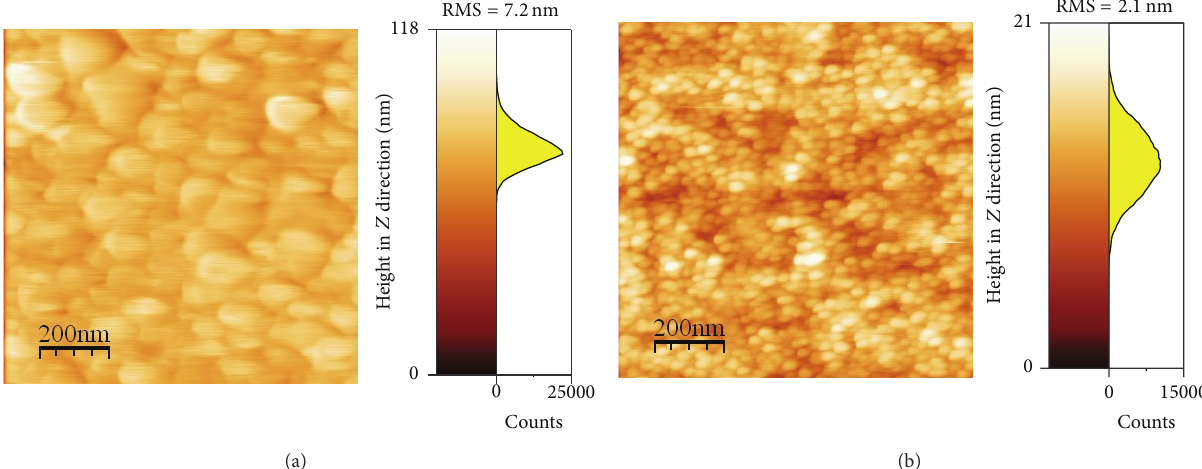
Figure 2: AFM images of (a) TiO 2 thin film and (b) TiO 2 :Tb thin film with height distribution of grains size in 𝑍 direction and surface roughness determined by RMS factor.